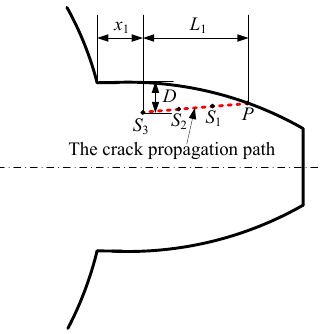
Figure 10. Schematic of surface crack propagation. Table 2. Parameters of surface crack propagation case.